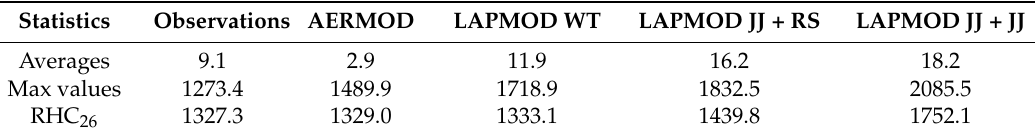
Table 7. Statistics for the Kincaid SO 2 observations (μg m −3 ).